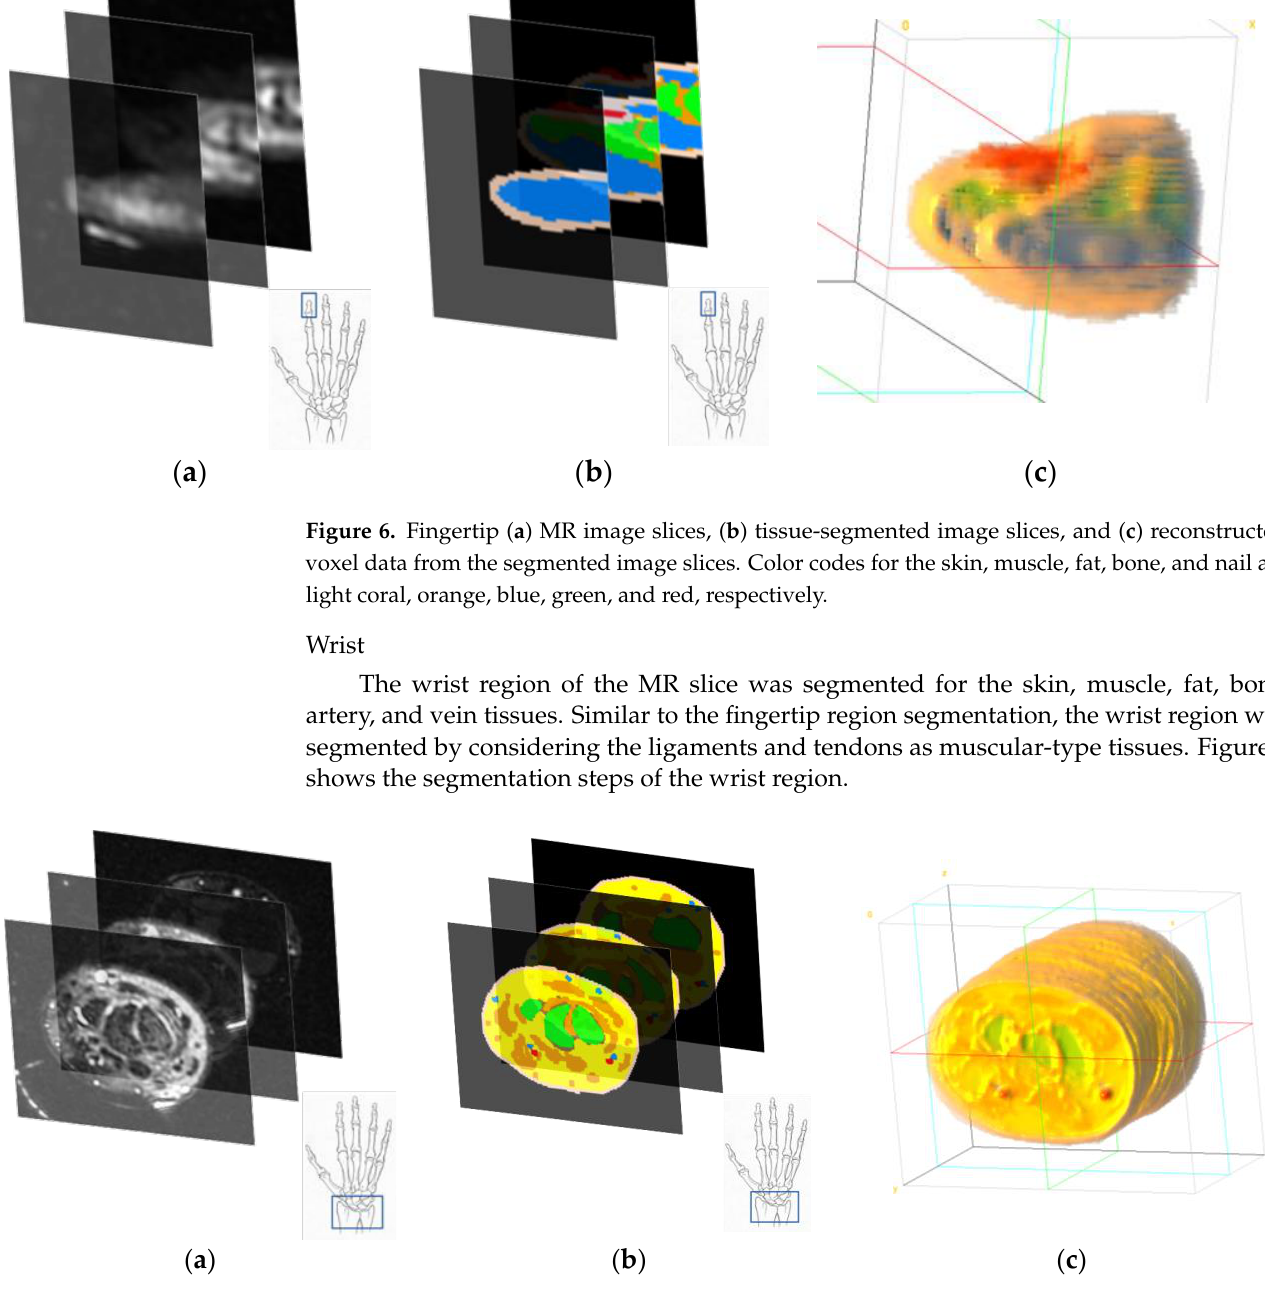
Figure 7. Wrist ( a ) MR image slices, ( b ) tissue-segmented image slices, and ( c ) reconstructed voxel data from the segmented image slices. Color codes for the skin, muscle, fat, bone, artery, and vein are light coral, orange, yellow, green, red, and blue, respectively.